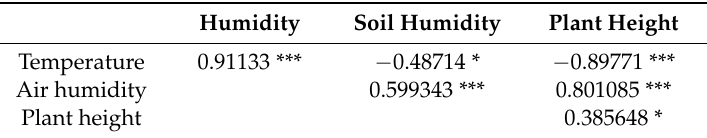
Table 1. Spearman correlation coefficients of measured microclimatic variables. In brackets the p